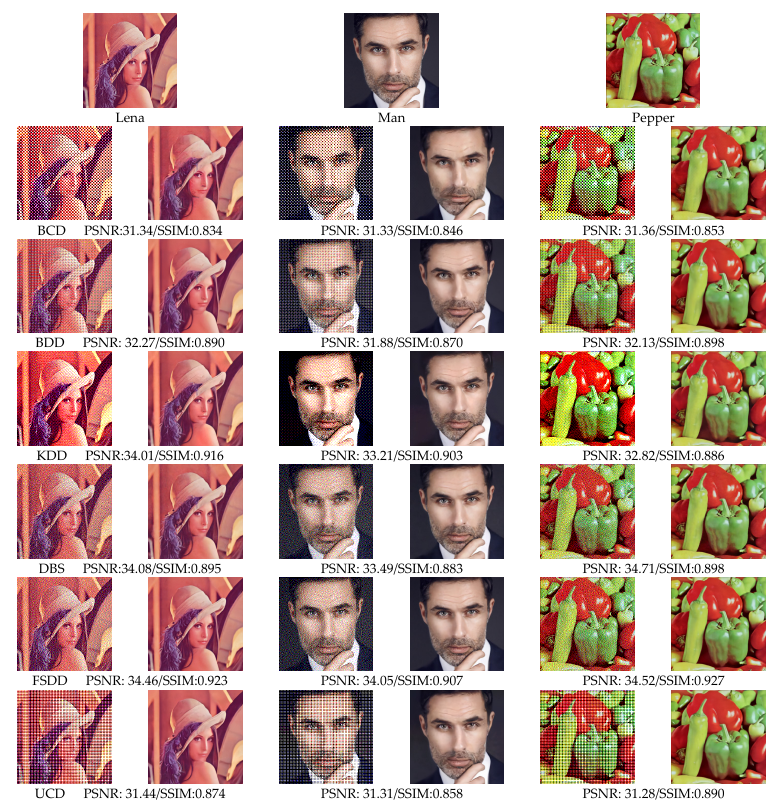
Figure 5. Experimental results of different types of halftone images for Lena, Man and Peppers images.